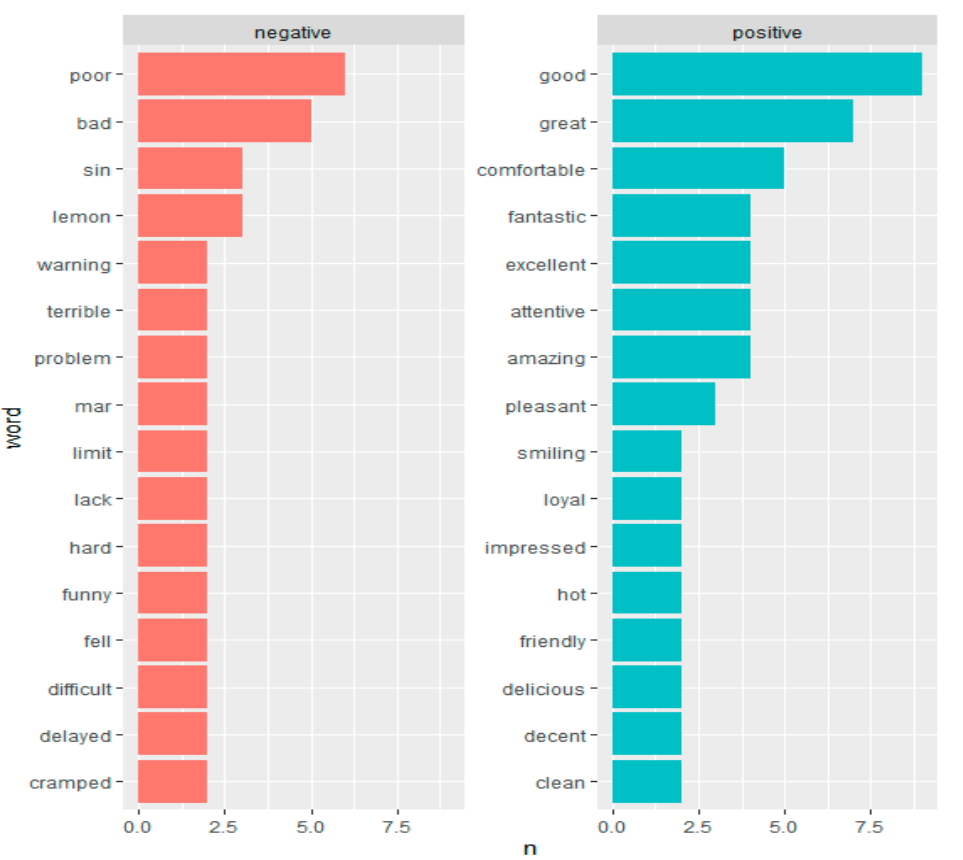
Figure 5. The result of sentiment analysis.